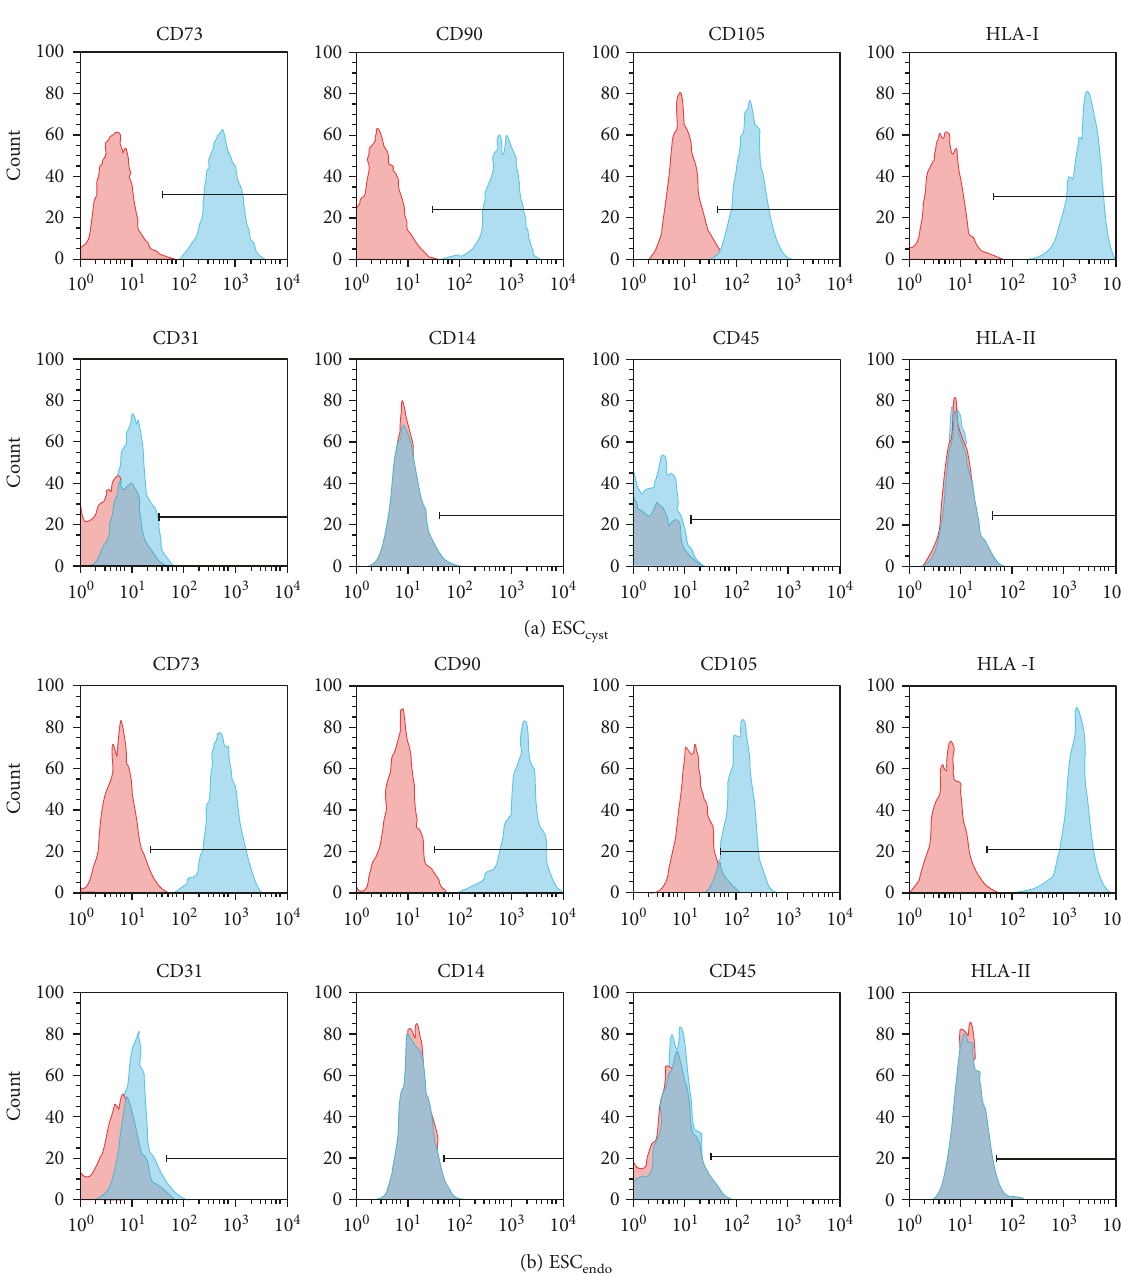
Figure 1: Representative fl ow cytometry histograms for ESC and ESC , which were positive ( ≥ 95%) for the MSC markers CD73, CD90, endo cyst CD105, and HLA class I and negative ( ≤ 5%) for the non-MSC markers CD14, CD45, CD31, and HLA class II. Unstained control cells are in red, and stained cells are in blue. The horizontal lines on the histograms show the percentage of expression of the markers compared to the unstained control cells. Five to seven independent experiments ( n = 3 biological replicates) were carried